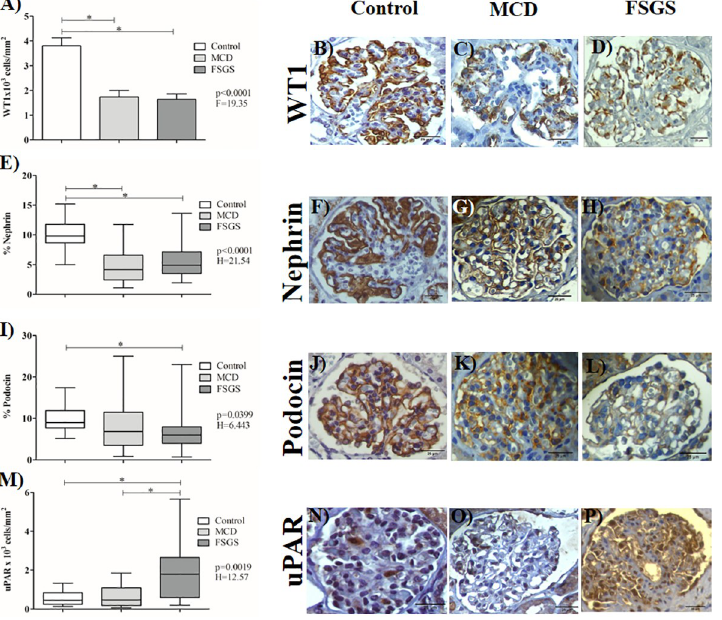
Fig 1. Expression of WT1, nephrin, podocin and uPAR in glomeruli by immunoperoxidase technique in the 3 groups: Control, MCD and FSGS. (A) Expression of WT1 in the 3 groups. ANOVA test followed by Tukey’s multiple comparison test when normal distribution and bars represent the mean and the line above represents the standard deviation. WT1 immunolabeling in glomeruli in control (B), MCD (C) and FSGS groups (D) (1600X). (E, I and M) Expression of nephrin, podocin and uPAR in the 3 groups. Kruskal-Wallis test followed by Dunn’s multiple comparison test when non-normal distribution and the horizontal lines represent the medians, the bars represent the 25–75% percentiles and the vertical lines represent the percentiles 10–90%. Nephrin immunolabeling in glomeruli in control (F), MCD (G) and FSGS (H) groups (1600X). Podocin immunolabeling in glomeruli in control (J), MCD (K) and FSGS groups (L) (1600X). uPAR immunolabeling in glomerular compartment in control (N), MCD (O) and FSGS groups (P) (1600X). � Statistical significance was defined as p < 0.05.